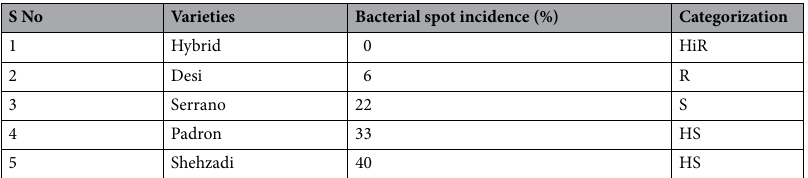
Table 1. Bacterial spot severity on five chilli cultivars challenged by a Xanthomonas spp., bacterial spot disease agent. Screening results of five Capsicum varieties under bacterial spot disease stress in greenhouse conditions. Chilli plants were grown in plastic pots, and after 21 days of growth, seedlings were inoculated with Xanthomonas campestris . Bacterial spot disease incidence was observed up to 60 days from the day of bacterial inoculation. HIR highly resistant, R resistant, S susceptible, and HS highly